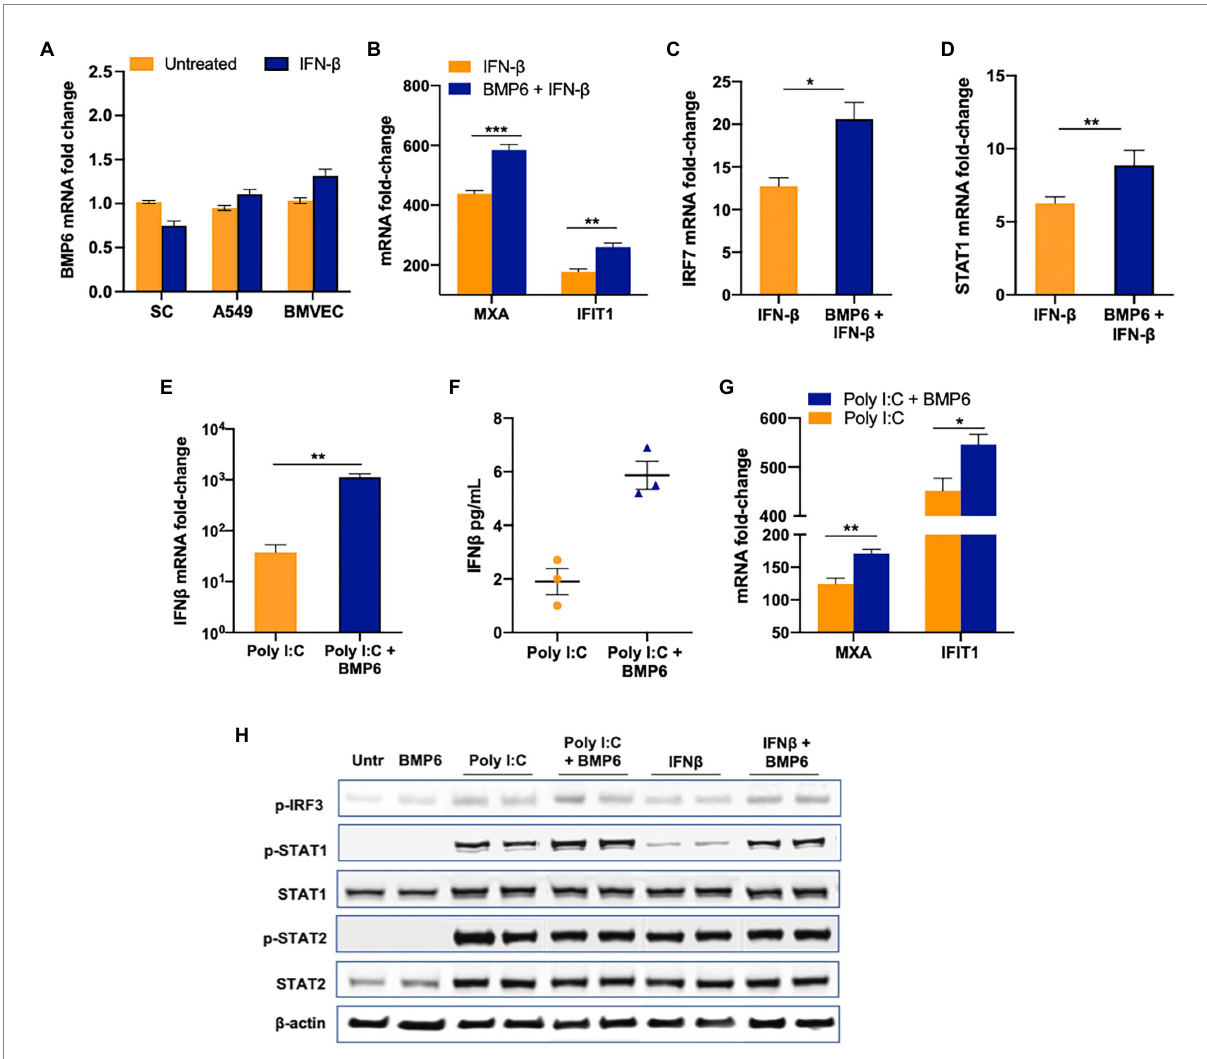
FIGURE 7 BMP6 enhances the antiviral response in SC. (A) BMP6 mRNA transcripts were measured in SC, A549, and BMVEC at 24 h post-treatment with 1 IU/mL of recombinant human IFN- β using RT-PCR. (B–D) SC were treated with recombinant human IFN- β in the presence and absence